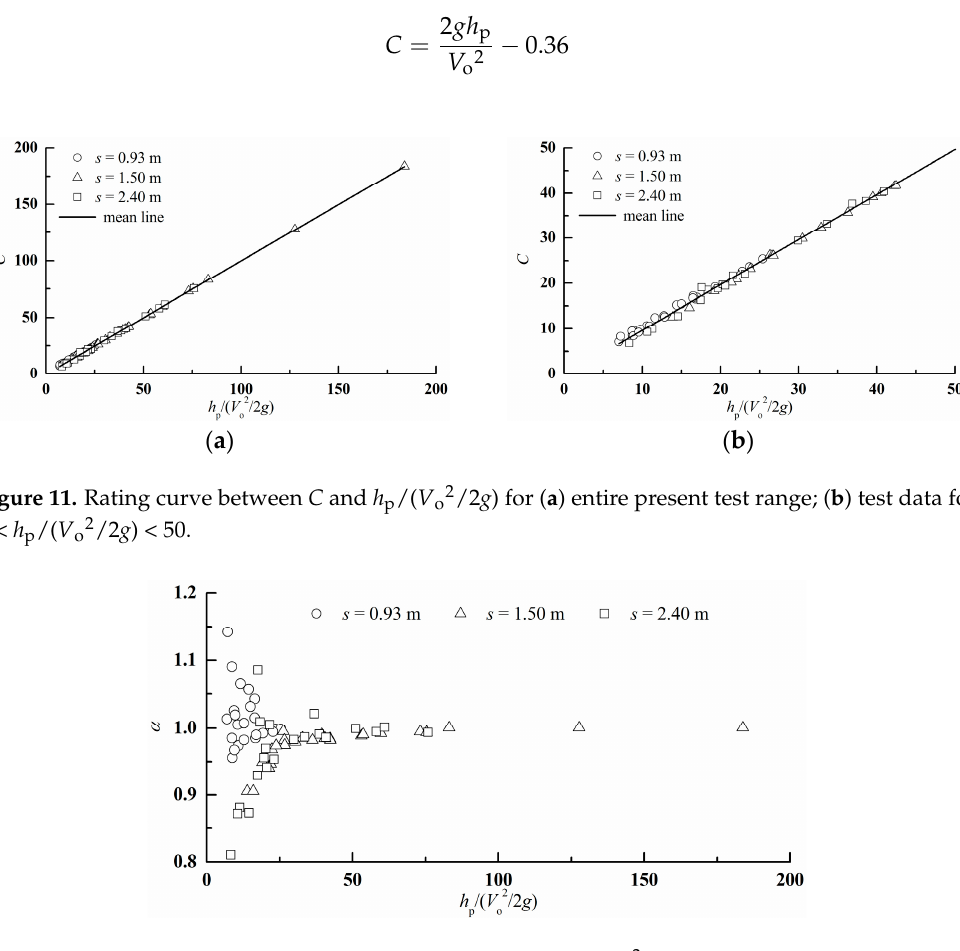
Figure 12. Variation of α with h p /( V o2 /2 g ).